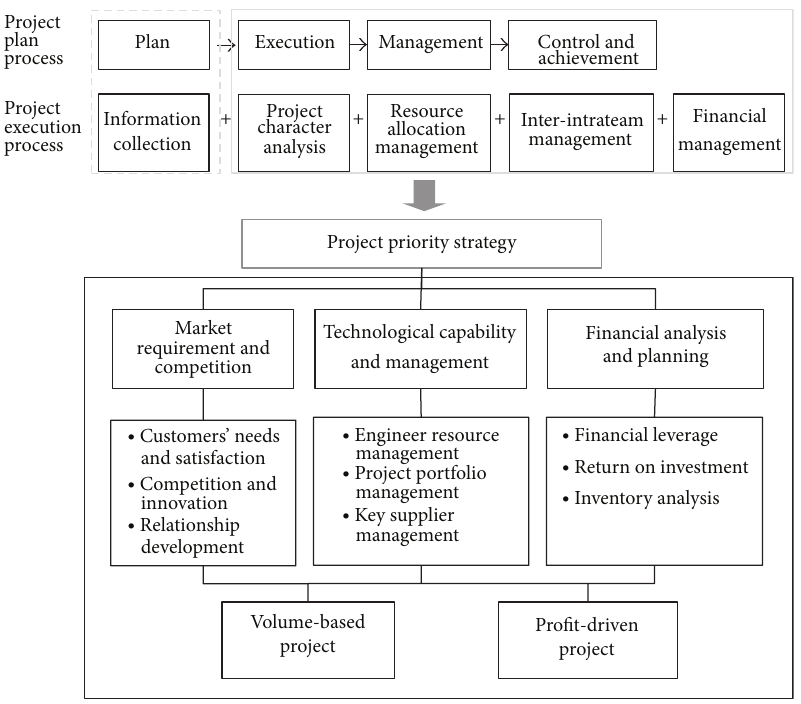
Figure 1: Project processes from planning and execution to project priority strategy